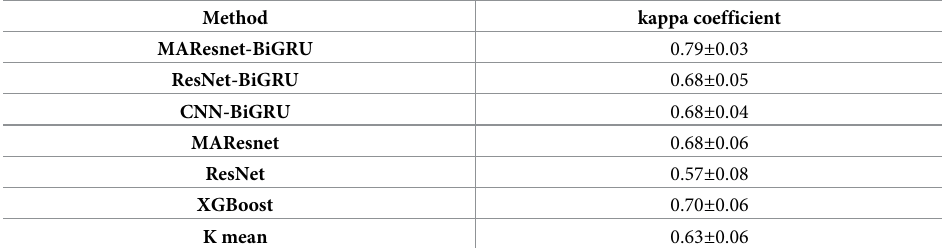
Table 6. Kappa coefficient under different algorithms.